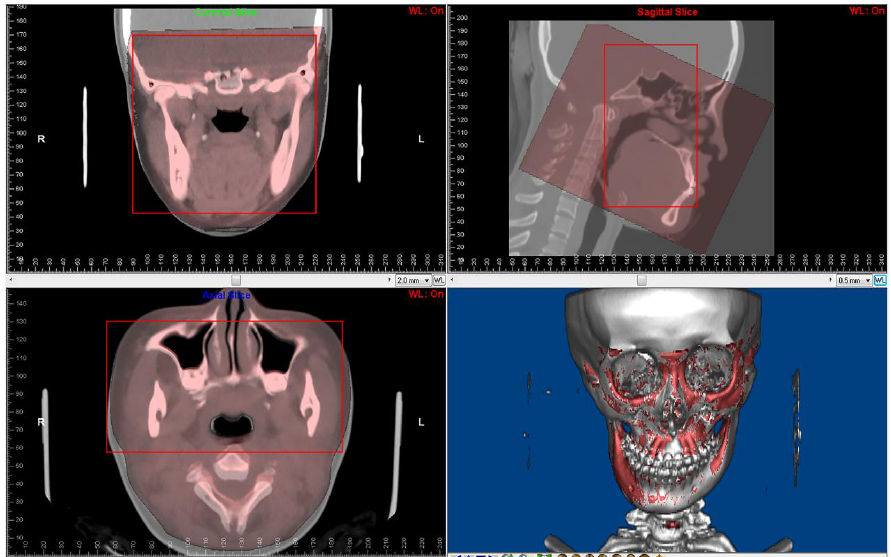
Figure 2. Superimposition of paired CT and CBCT was performed using Dolphin3D imaging software. The red squares are regions for superimposition.